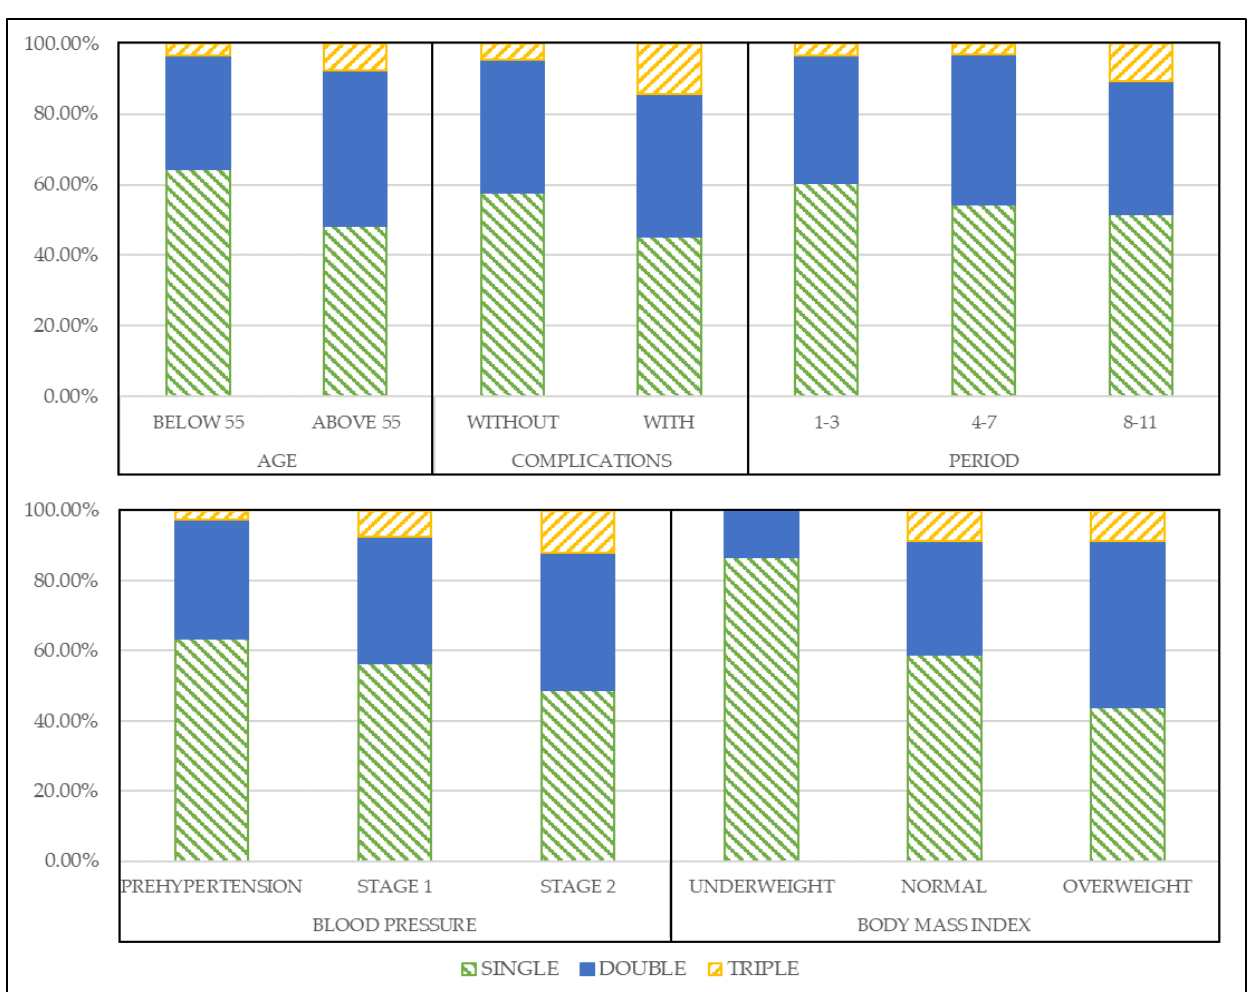
Figure 2. Distributions of recommended medications by model.